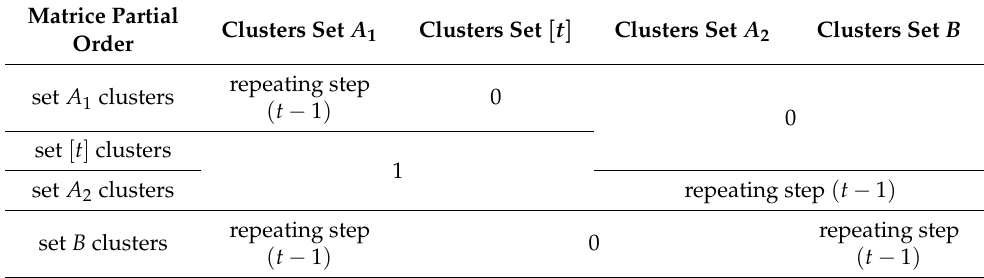
Table 1. Algorithm of transition from step t − 1 to step t for a matrix of partial order a